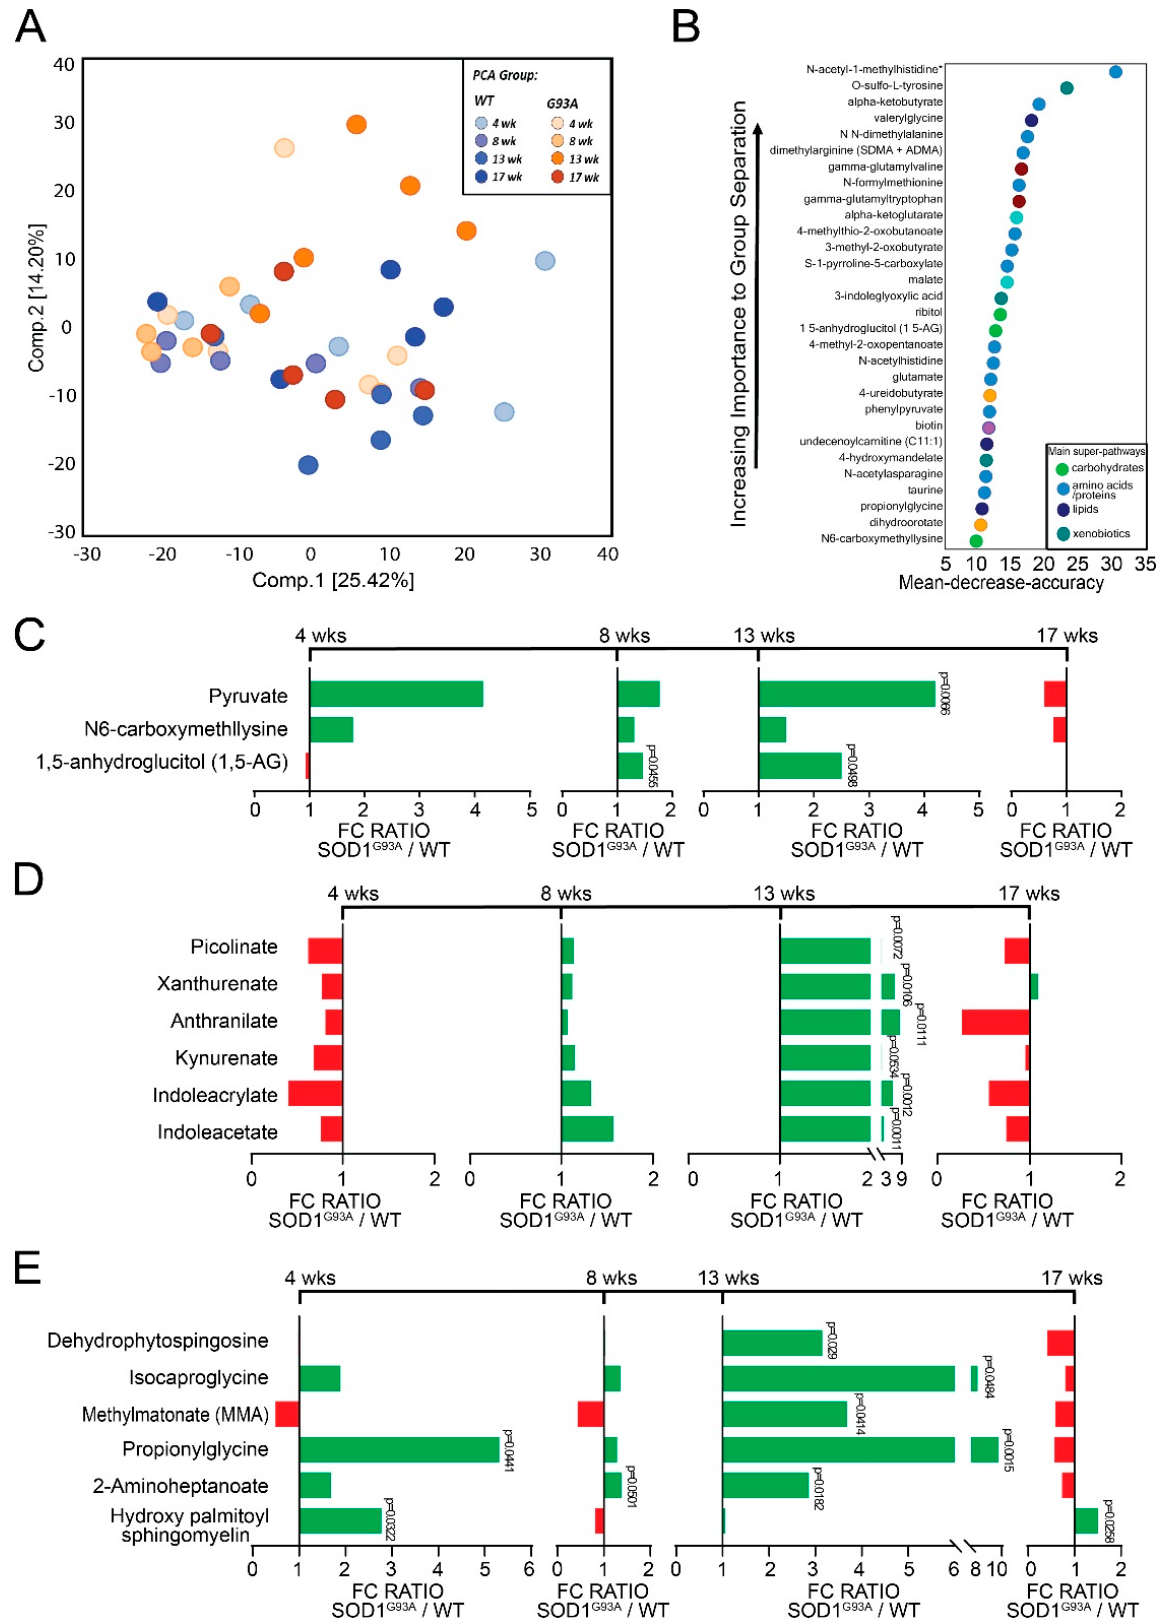
Figure 1. Impact of butyrate treatment on metabolite profile in ALS mice over the course of the disease. ( A ) PCA comparing the biochemical similarity between WT and SOD1 G93A mice over the course of disease. ( B ) Random forest (RF) analysis showing the top 30 most important metabolites that differed between WT and SOD1 G93A mice over the course of disease. The variables are ordered top to bottom as most to least important. Different colors indicate specific metabolites resulting from different superpathways: green = carbohydrate, light blue = amino acid, blue = lipids, and teal = xenobiotics. Biochemical Name * indicates compounds that have not been officially confirmed based on a standard, but the identity was confirmed by Metabolon (Morrisville, NC, USA). ( C – E ) Welch’s